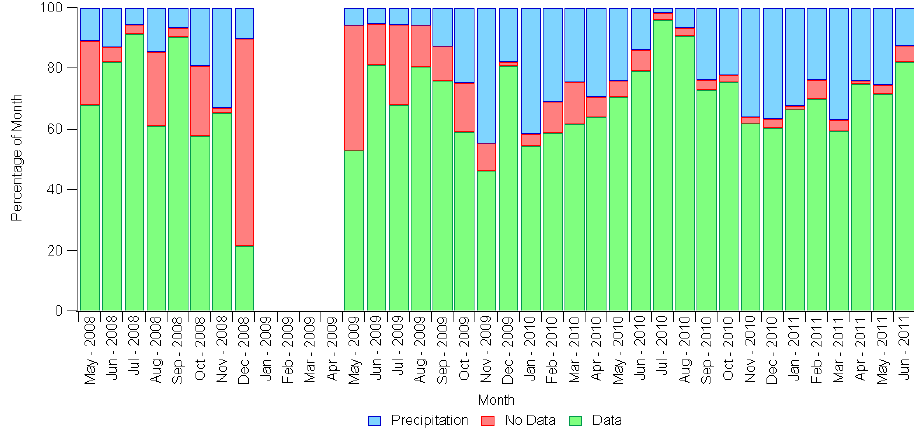
Fig. 6. Graph showing the same information as in Fig. 5 for CORALNet UBC, but for the entire operational